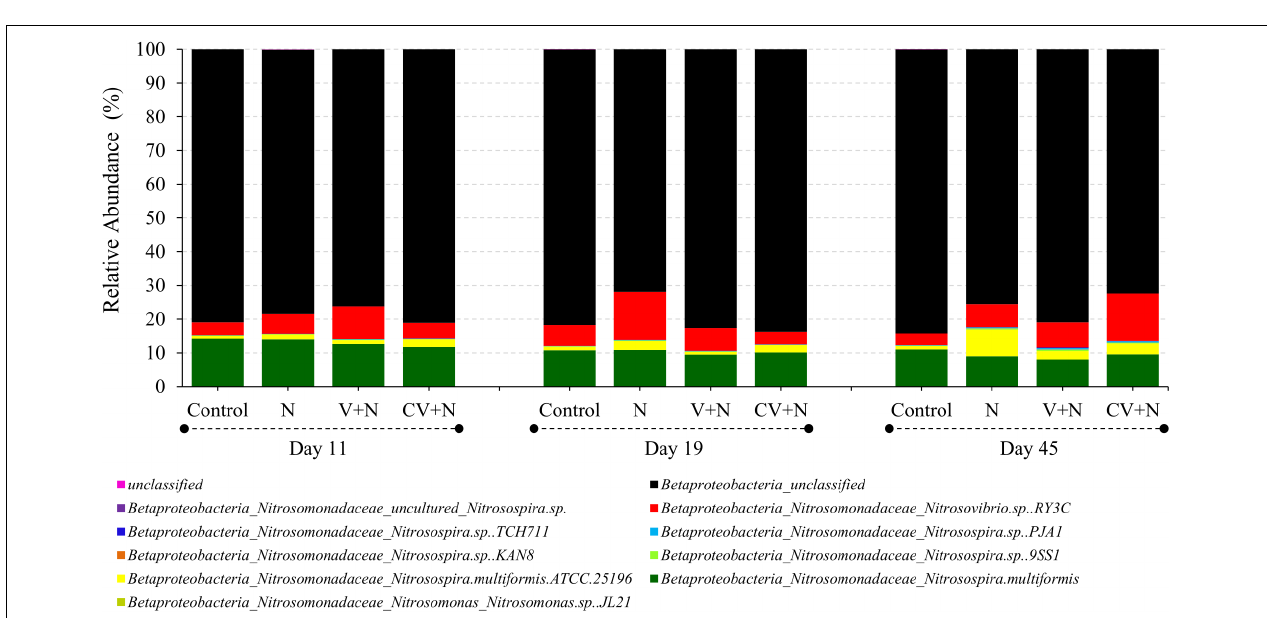
FIGURE 1 | Summary of Spearman’s correlations between N 2 O emission flux (mg N m − 2 d − 1 ) and environmental variables, the abundance of bacterial amo A-AOB gene (gene copy g − 1 dry soil) and the 16S rDNA /amo A ratio ( n = 36). Black bold lines mean significant correlation, red bold lines significant negative correlation, and dotted lines no correlation between variables ( n = 36). Significant difference: ∗ p ≤ 0.10, ∗∗ p ≤ 0.05, and ∗∗∗ p ≤ 0.01. Abbreviations: WFPS, Water-filled pore space; AOB, amo A belonging to ammonia-oxidizing bacteria (AOB).